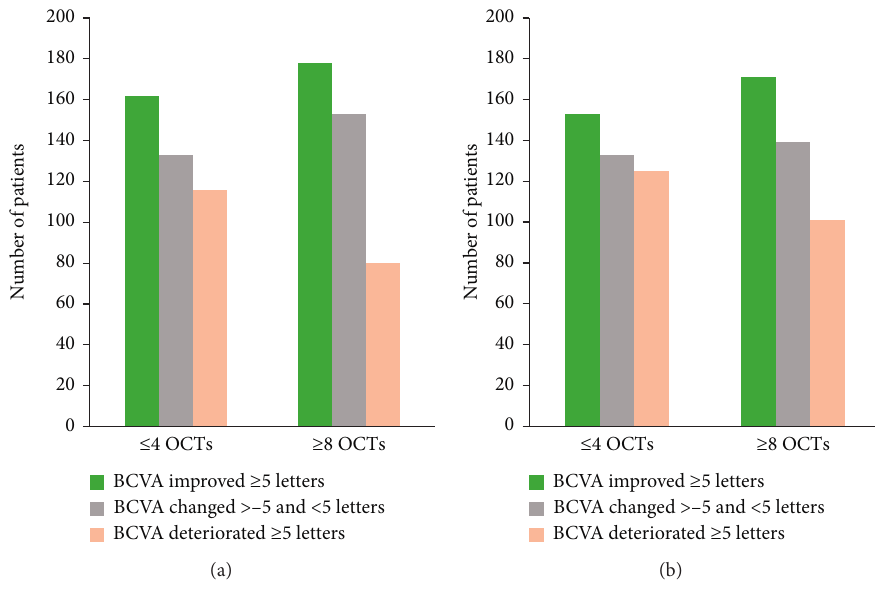
Figure 5: Treatment response from baseline to 12 and 24 months for patients receiving ≤ 4 OCTor ≥ 8 OCTexaminations for the matched sample ( N � 411 for both groups). BCVA: best-corrected visual acuity; OCT: optical coherence tomography. (a) 12 months; (b) 24 months.